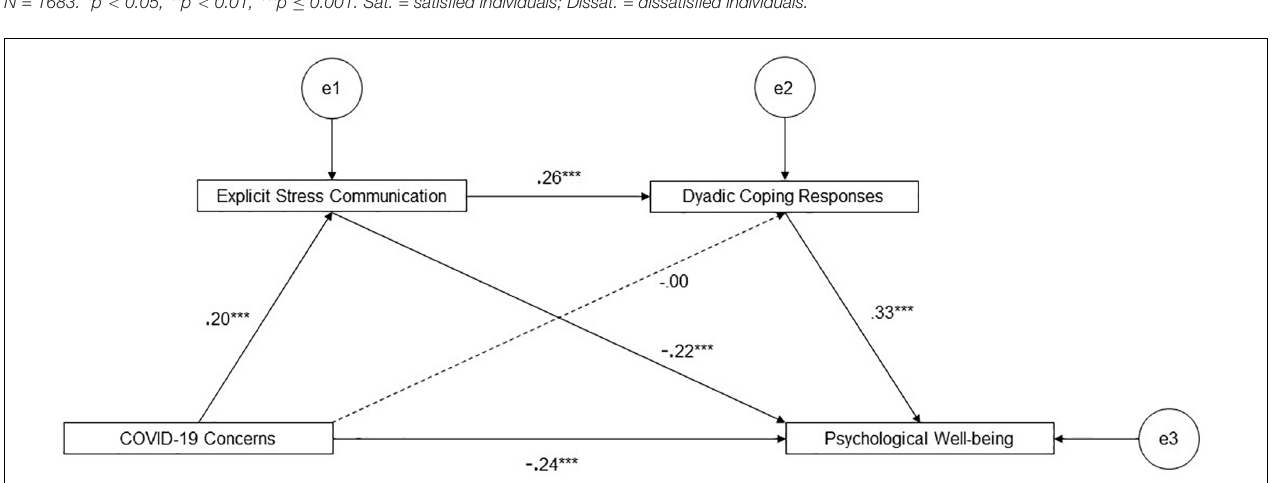
FIGURE 1 | Serial mediation model. Path coefficients are standardized estimates. *** p ≤